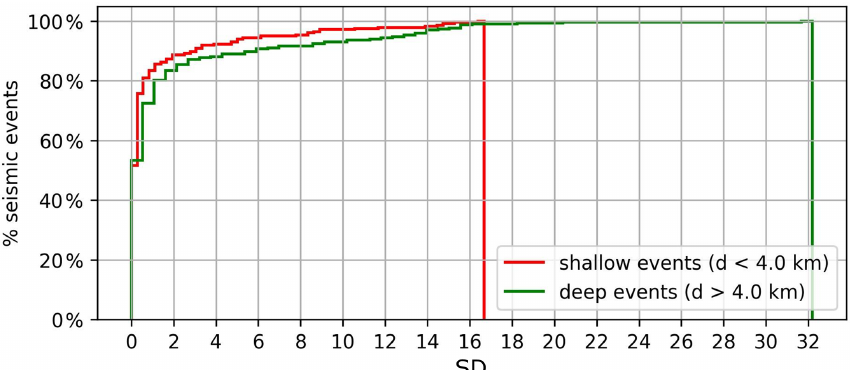
Figure 8. Cumulative plot shows the standard deviation of the location results for shallow in-network (in red) an deep outside-network (green)